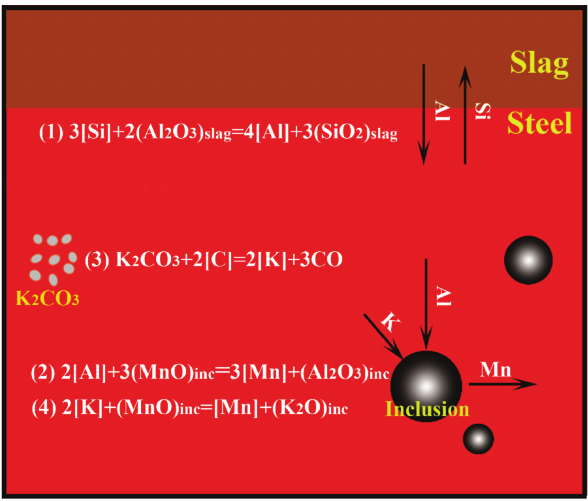
Figure 6: Schematic diagram of the reaction mechanism between K 2 CO 3